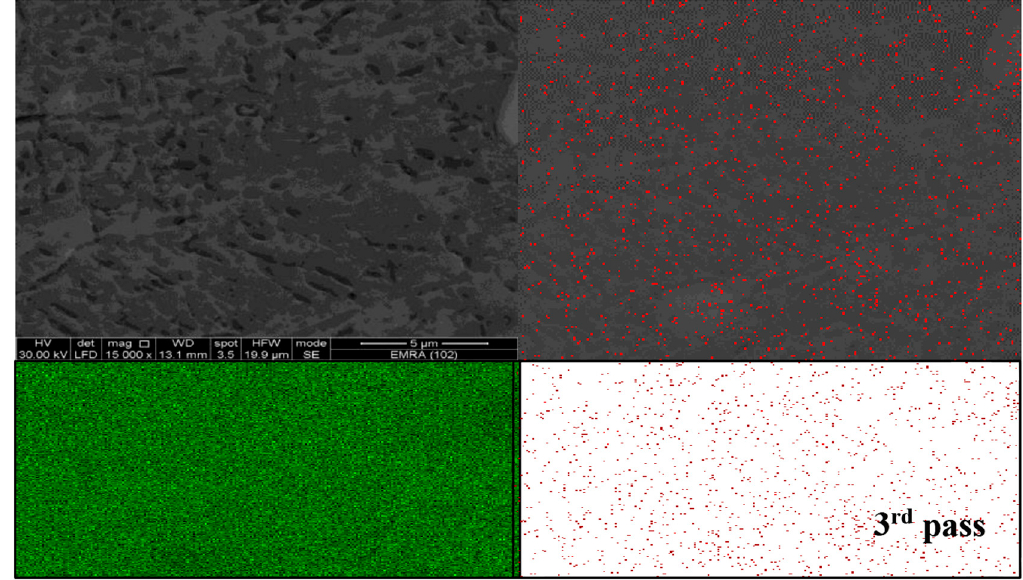
Figure 14. Elemental map of MMNCs and EDS analysis in FSP after the third pass at 1120 rpm at 10 mm/min.